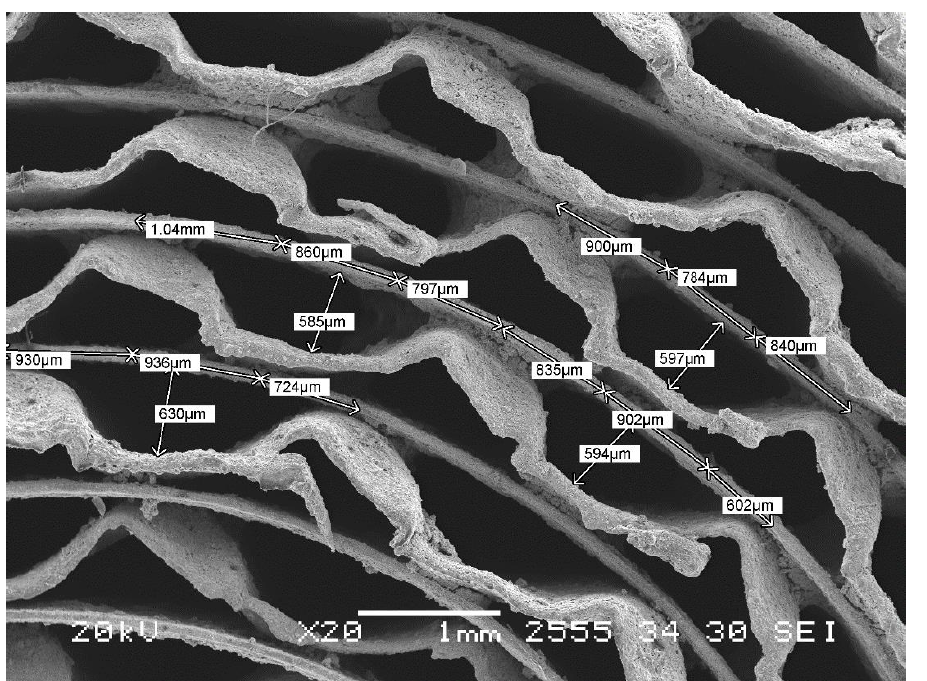
Figure 1. SEM image of the honeycomb catalytic monolith.